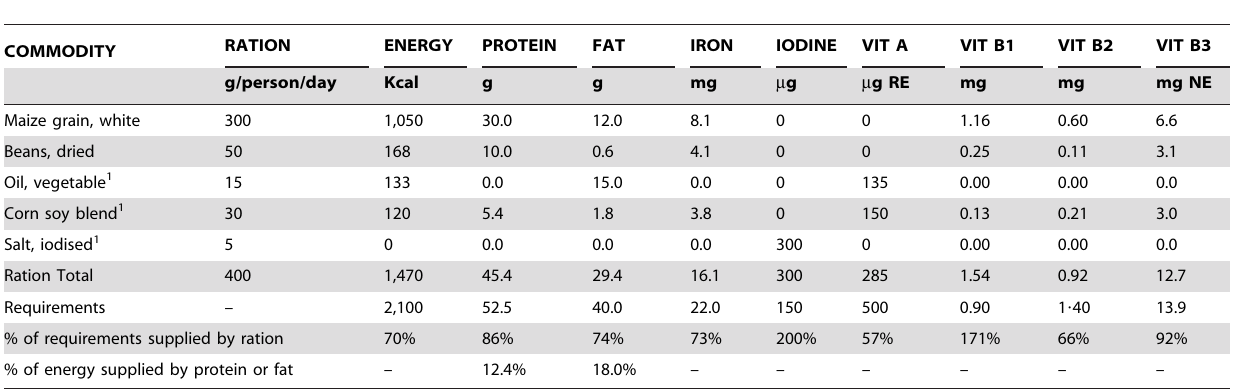
Table 2. Nutritional content of ration calculated on a planned 30 day cycle, Kotido District (neighboring Nakapiripirit District), Karamoja, Uganda, April – December 2009, NutVal 2006 V 2 ?